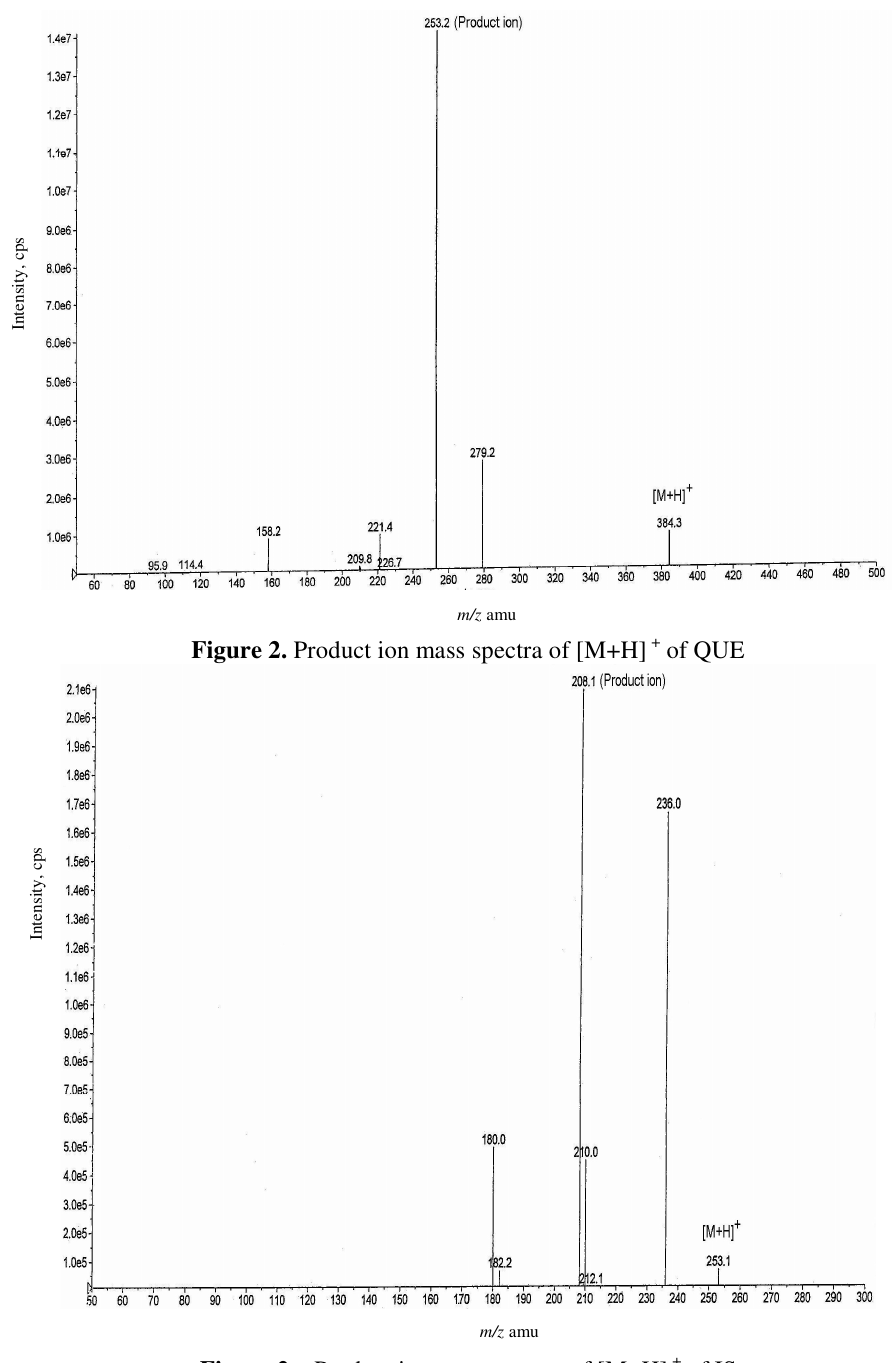
Figure 2a. Product ion mass spectra of [M+H] + of